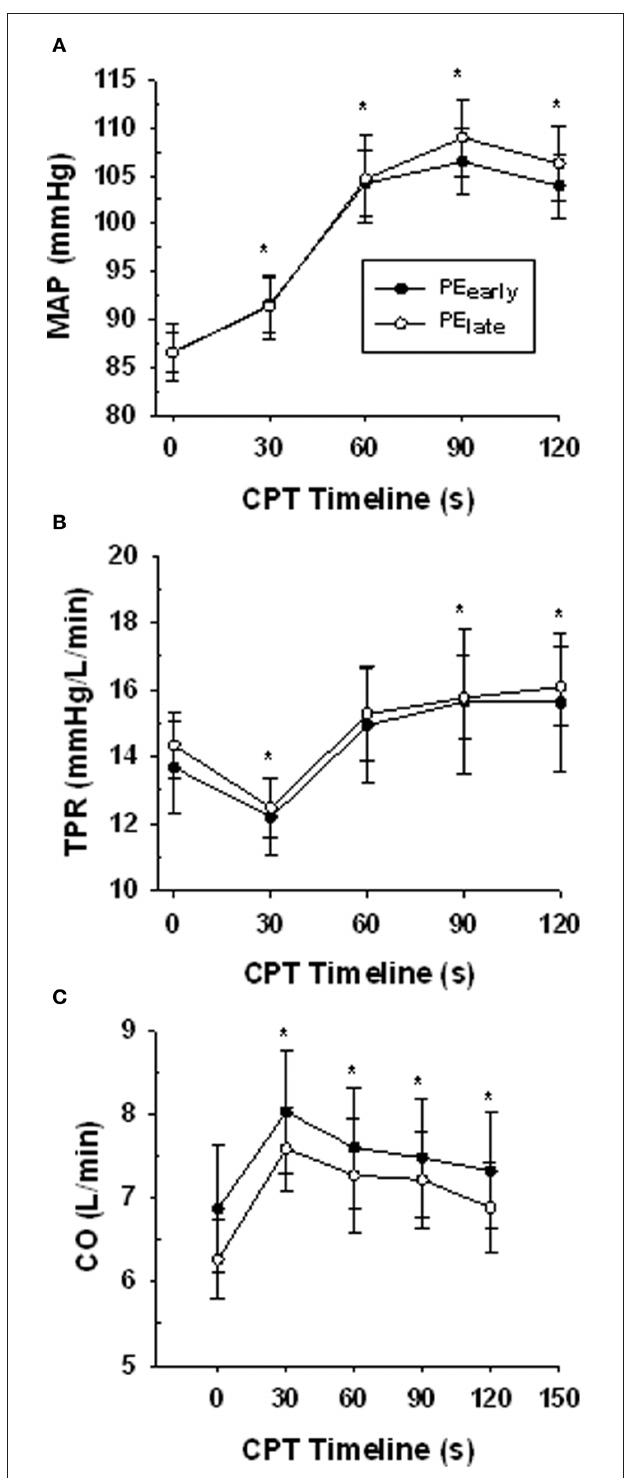
FIGURE 4 | Central hemodynamic responses over the course of the CPT during the resting trial on the PE early and PE late experimental days. Panel (A) mean arterial pressure (MAP). Panel (B) total peripheral resistance (TPR). Panel (C) cardiac output (CO). ∗ indicates significantly different from time 0 (baseline) for both PE early and PE late P < 0 . 05.